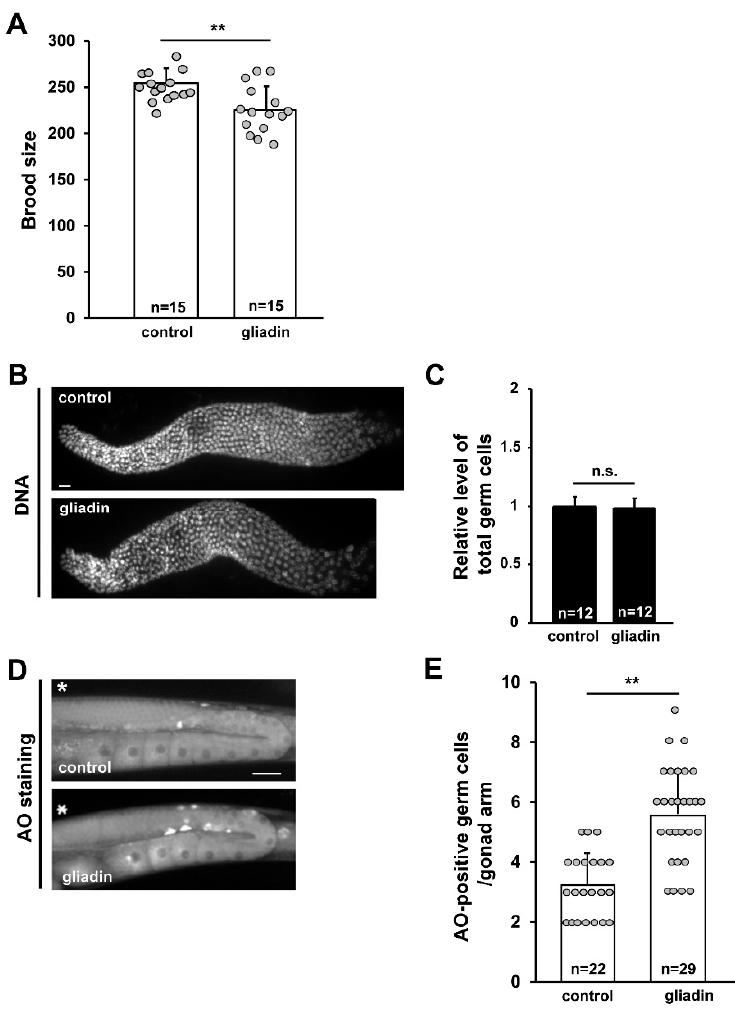
Figure 7. Effect of gliadin intake on germ cell proliferation and apoptosis in adult wild-type N2 C. elegans worms. ( A ) The brood size of gliadin-treated mothers compared to control mothers after 4 days. ** p < 0.005. ( B,C ) Germ cell proliferation was not affected by gliadin treatment. Wild-type N2 worms synchronized at the L4 larval stage were treated with or without gliadin for 24 h, and dissected gonads were DNA-stained using TO-PRO-3. Bar graph ( C ) shows relative levels of germ cell proliferation of gliadin-treated worms compared to control worms. ( D,E ) Germ cell apoptosis increases with gliadin treatment as indicated by staining apoptotic germ cells with acridine orange (AO). *, Distal end of each gonad arm. Bar, 20 µm. ** p < 0.005 (Student’s t -test).